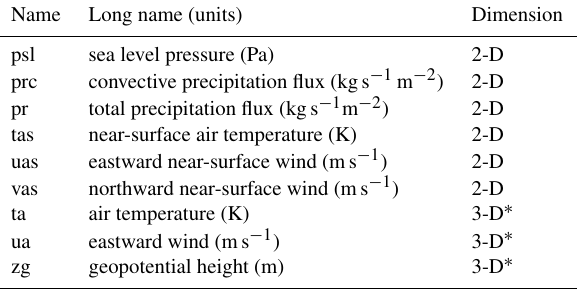
Table 1. Climate and variability. Monthly and daily means, with 2-D indicating a longitude–latitude–time (XYT) field and 3-D indi- cating a longitude–latitude–pressure–time (XYPT) field. XY is typ- ically the model’s horizontal output grid and P is the standard 30- level set of diagnostic pressure levels described in Sect. 4.1: